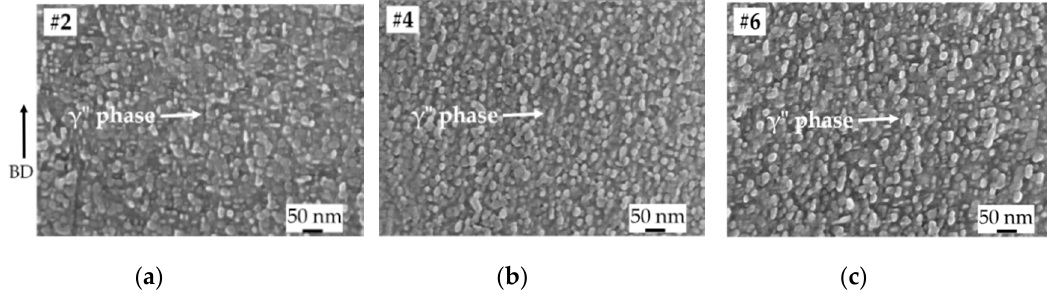
Figure 6. SEM micrographs of HIP1 + STA samples ( a ) LS = 125 µm, ( b ) LS = 225 µm, and ( c ) LS = 325 µm showing similar distribution of the γ″ phase. The arrow indicates the build direction.